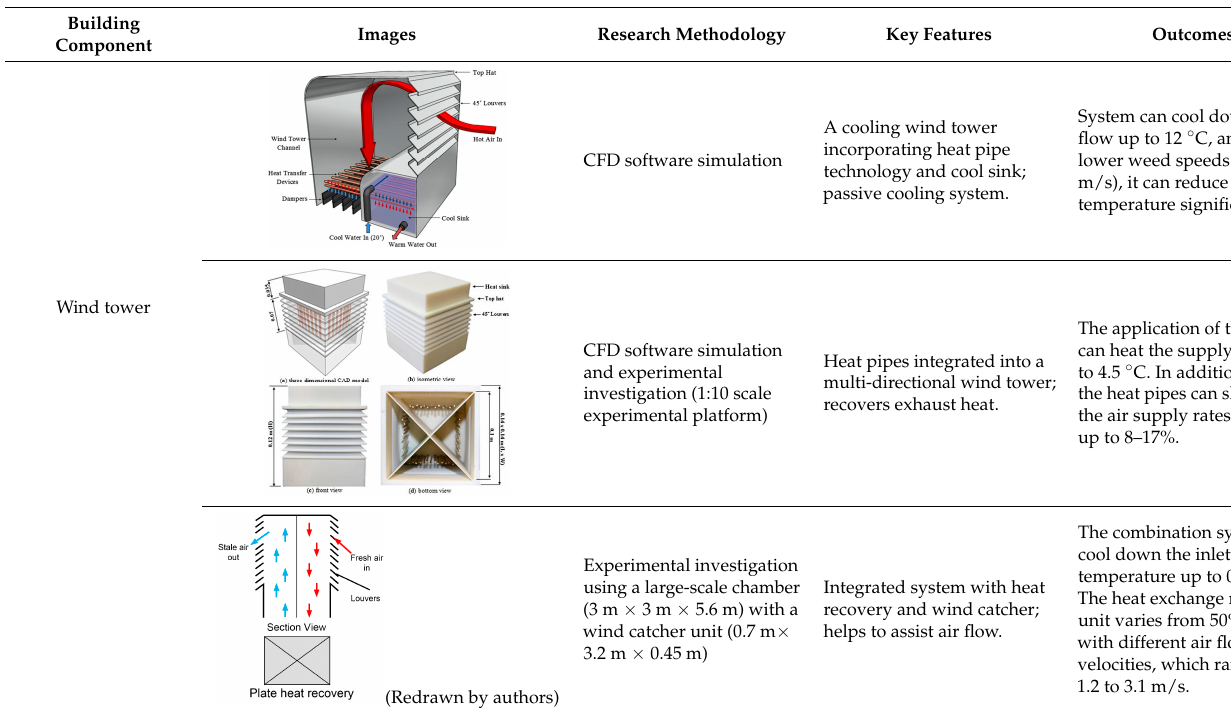
Table 3. A summary of heat recovery systems integrated into building